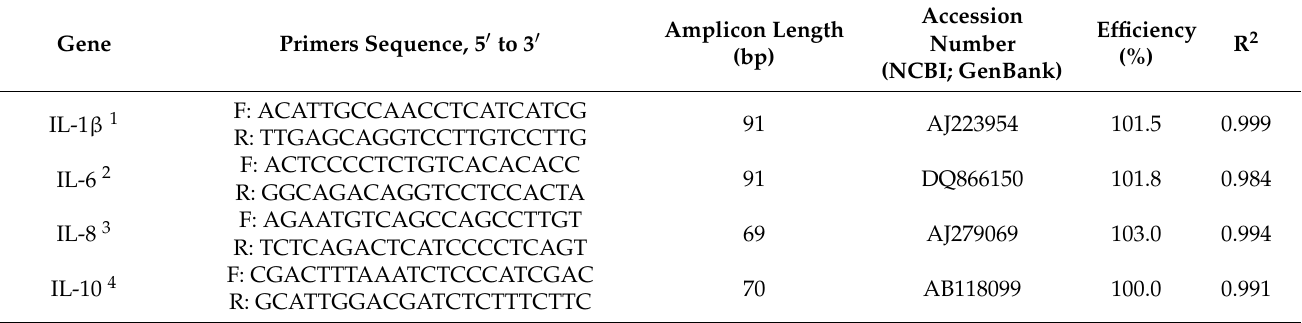
Table 1. Primer sequences, amplification products, and amplification efficiency for target and reference